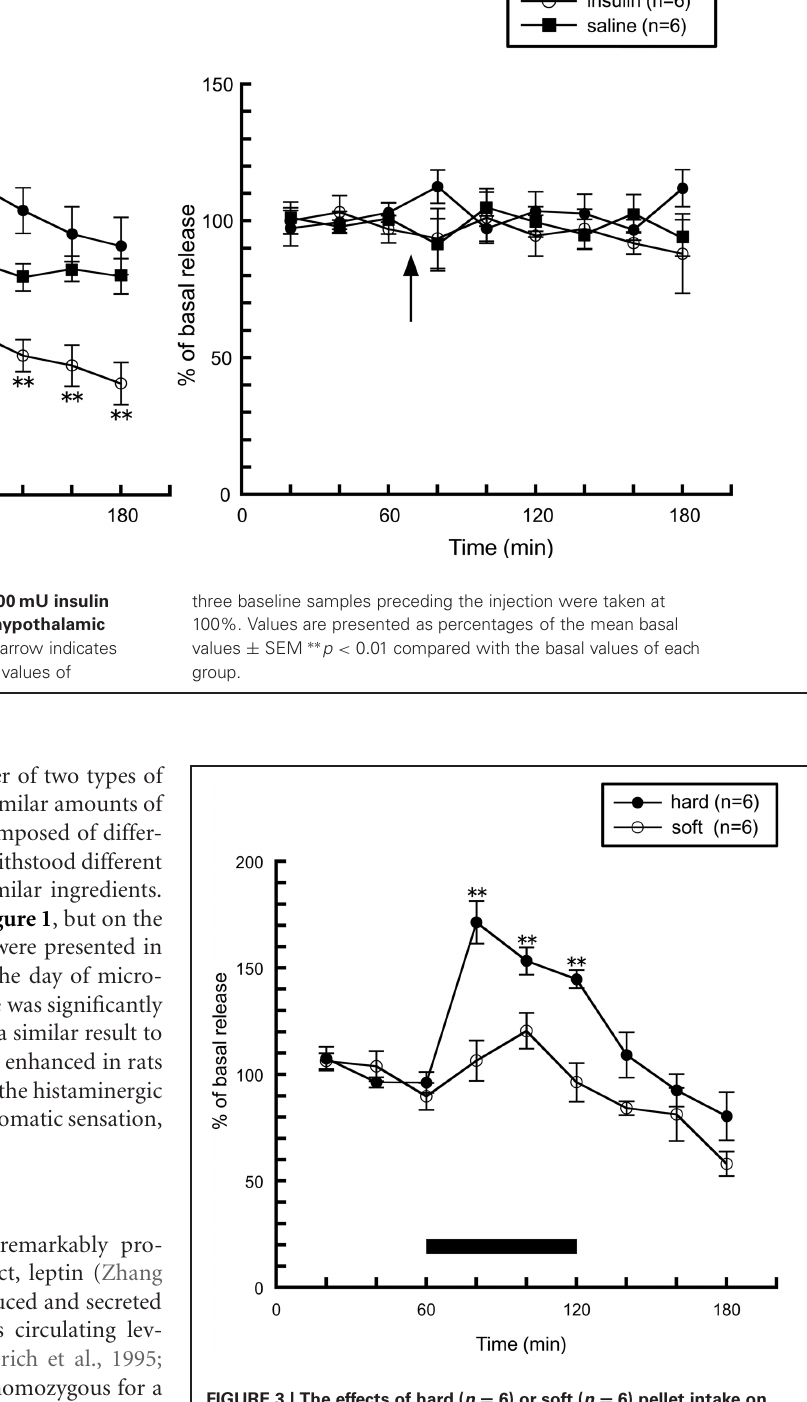
FIGURE 3 | The effects of hard ( n = 6) or soft ( n = 6) pellet intake on amygdalar histamine release in freely moving rats [Ishizuka et al. (2010)]. The black bar indicates the 60min period when food was available. The mean values of three baseline samples preceding the feeding period were taken as 100%. Values are presented as percentages of the mean basal release ± SEM ∗∗ p < 0 . 01 compared with the basal release of each group,